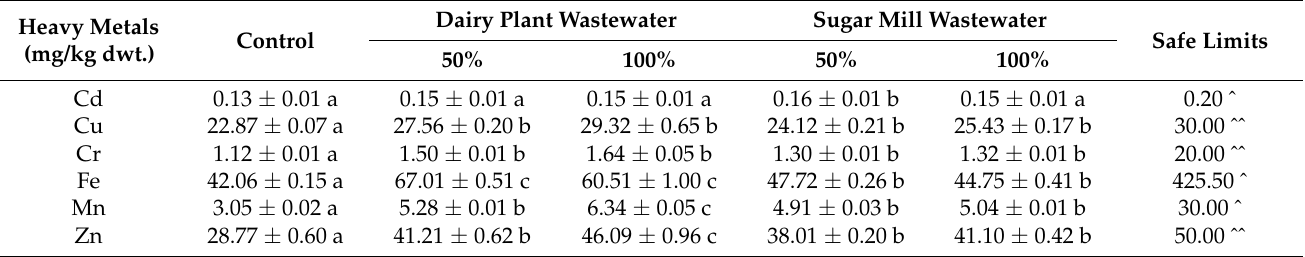
Table 4. Heavy metal contents in Shiitake ( L. edodes ) mushroom fruiting bodies cultivated on agro- industrial wastewaters treated substrate.